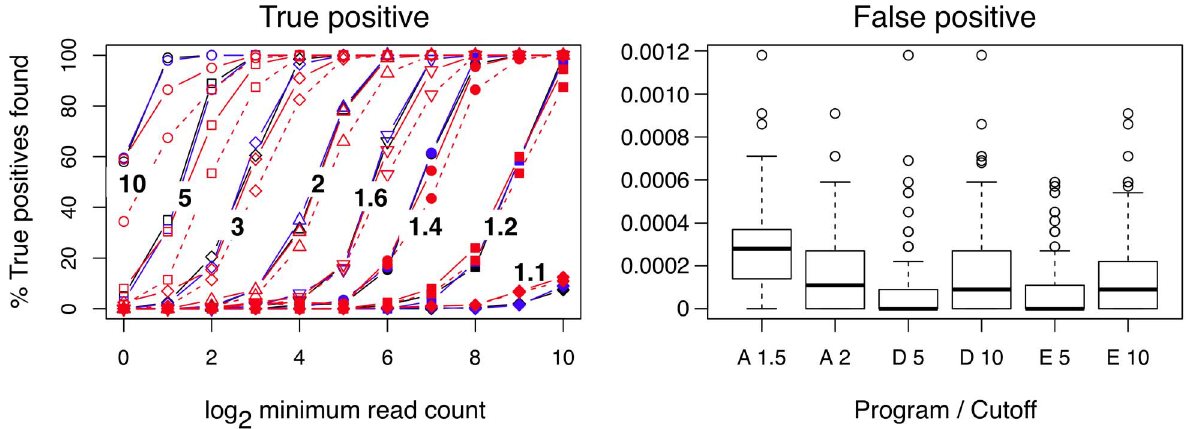
Figure 7. True and False positive identification in simulated data. A set of eleven genes with simulated read counts between 1 and 1024 in two-fold increments were appended twice to a single sample of the B. cereus dataset. Two conditions were generated by multiplying the counts for a single set of simulated genes in each condition by the fold-difference values indicated in the True positive panel on the left, and two simulated technical replicates were generated for each condition by sampling from the Dirichlet distribution which accurately models technical variance in these datasets (Figure 1). The resulting four samples were examined by DESeq, edgeR and ALDEx for the ability of each method to identify the simulated differentially-expressed genes. The fold change varied between 1.1 and 10 and 100 simulations were run for each fold change. The fold change value is overlaid on the corresponding curve in the left panel. The line colors are black for edgeR, blue for DESeq and red for ALDEx, and the cutoff of 1.5 is a solid and 2.0 is a dashed line. The right panel symbols are the same for each fold change value across each method. The ALDEx D 50 R shows the per-gene false positive rate for each method at two cutoffs. False positive events in this model can only arise through outliers in the Dirichlet sampling procedure. The rate was calculated by dividing the number of false positive genes identified in each trial by the number of genes in the dataset (5358). The boxplot shows the range of false positive rates observed for each method across all trials and all expression levels. A rate of 0.0002 corresponds to approximately 1 false positive per trial in this